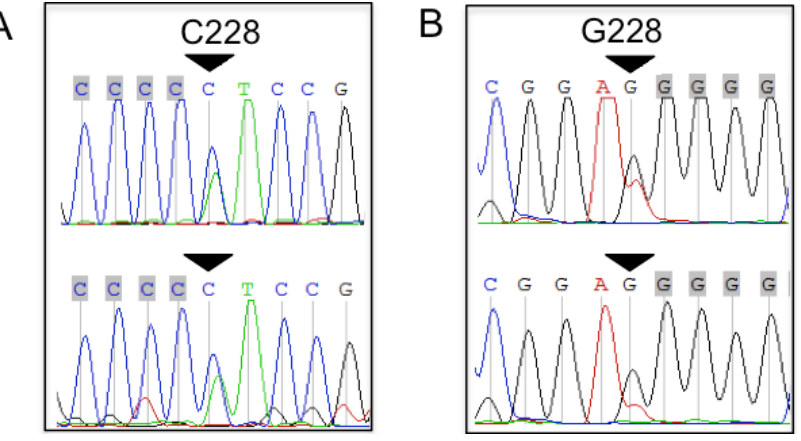
Figure 1. Representative chromatograms of heterozygous TERT promoter mutations in two bone and soft tissue sarcomas. Sequencing direction: ( A ) sense, ( B ) antisense. An arrow indicates mutations. Table 1. Overview of the frequency of TERT promoter mutations in soft tissue and bone sarcomas reported in the literature: Number of mutated cases/total cases (mutation rate, in percentage).